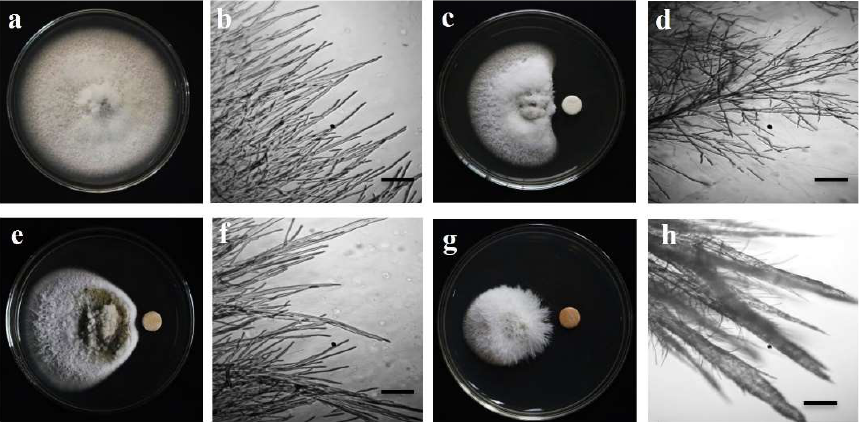
Figure 2. Photographs and micrographs of in vitro antifungal activity of staurosporine, chelerythrine chloride and a commercial fungicide, Nativo ® 75WG against wheat blast fungus, Magnaporthe oryzae Triticum (MoT) at 20 µg/disk. ( a ) Mycelial growth of MoT on PDA (control). ( b ) Normal tubular hyphal growth in a control. ( c ) Inhibition of MoT mycelial growth by chelerythrine chloride. ( d ) Disrupted tubular growth of MoT hyphae in the presence of chelerythrine chloride. ( e ) Inhibition of MoT mycelial growth by staurosporine. ( f ) Disrupted tubular growth and excessive branching in MoT hyphae in the presence of staurosporine. ( g ) Inhibition of MoT mycelial growth by Nativo ® 75WG. ( h ) Abnormal growth and necrosis in MoT hyphae in the presence of Nativo ® 75WG. Bar = 50 µm.